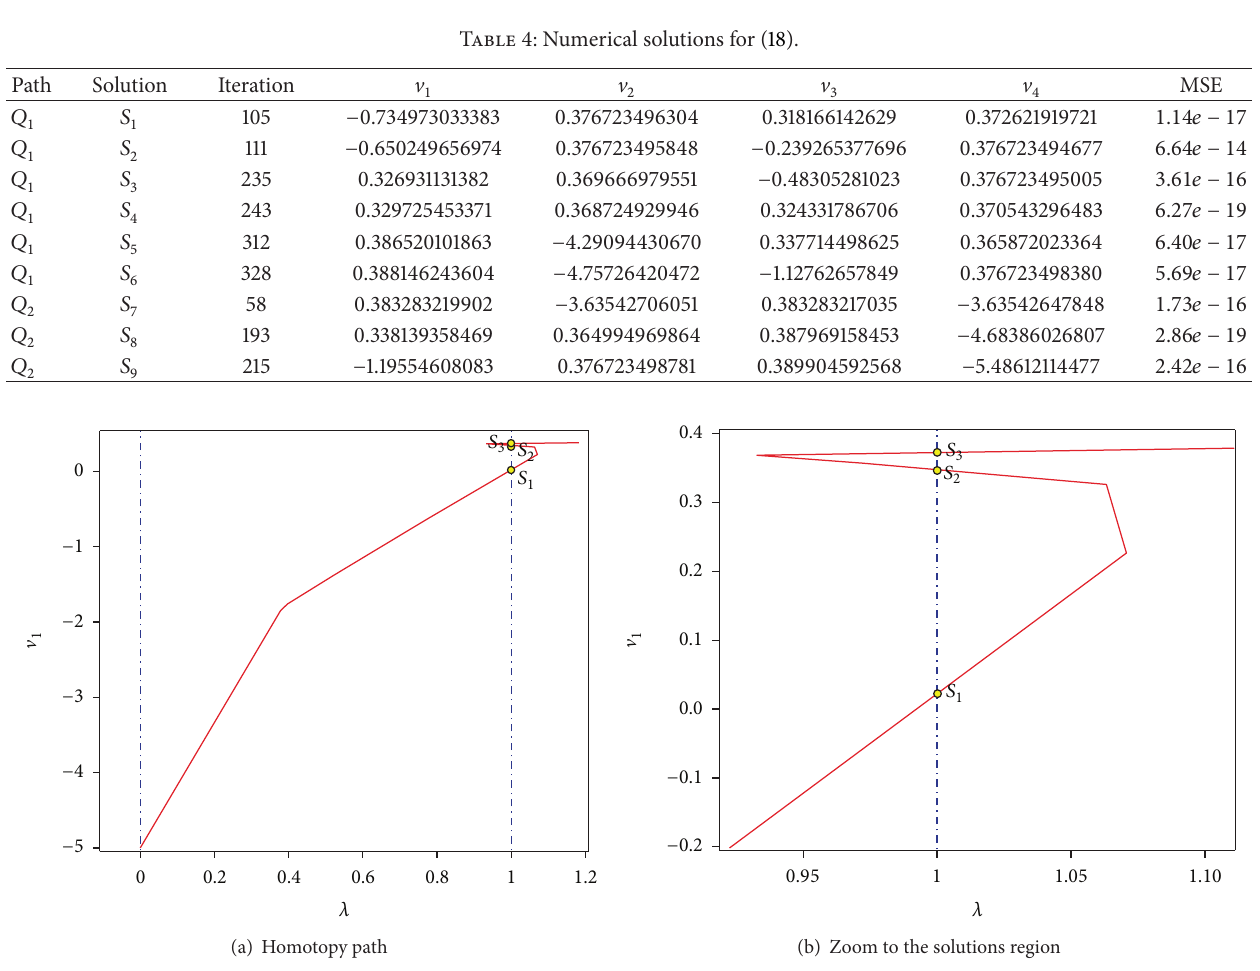
Figure 9: Homotopy path for (17) projected over 𝜆 - V 1 .